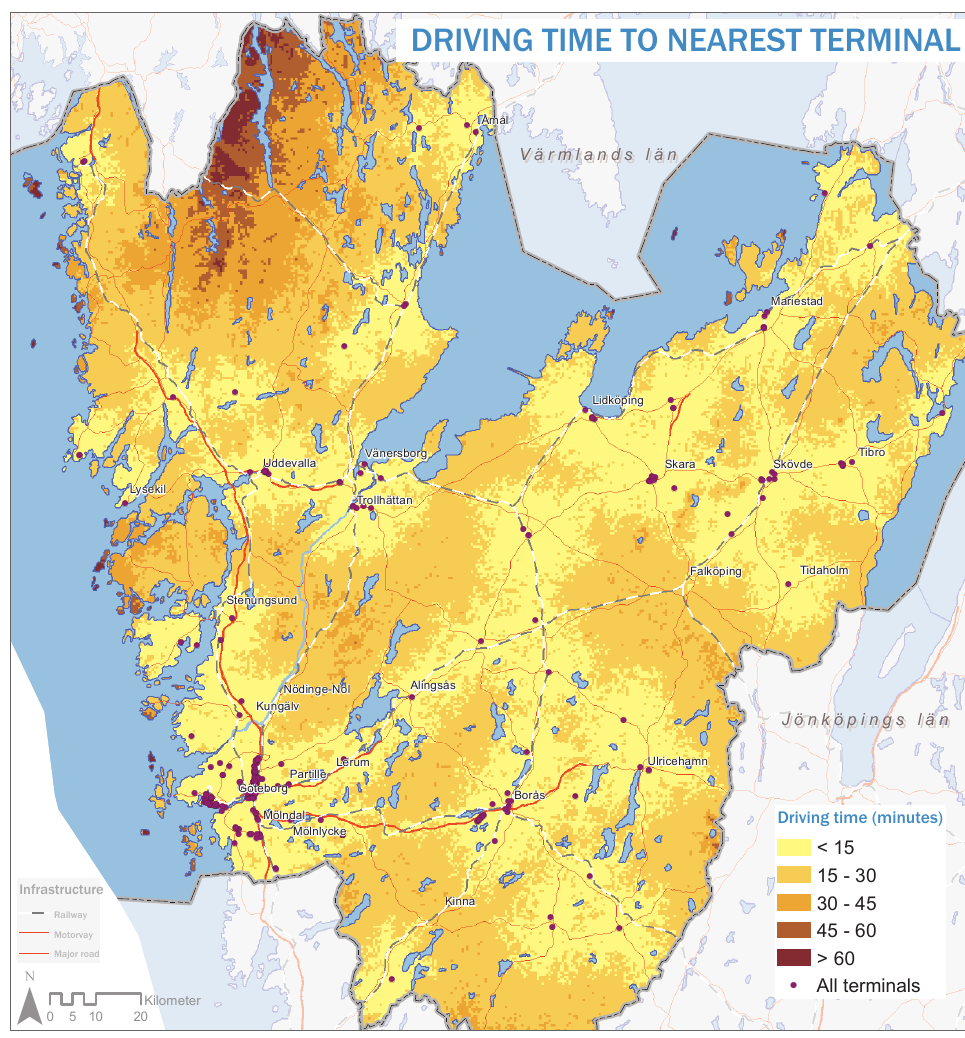
Figure 3: Accessibility in terms of driving time to the nearest